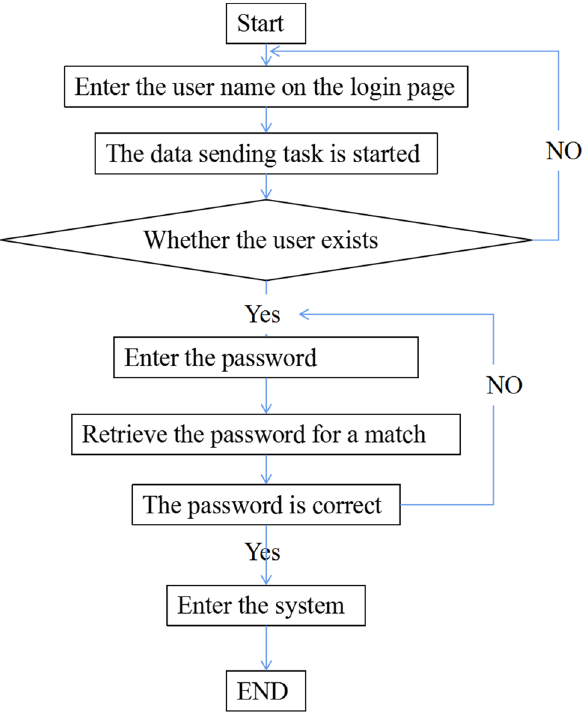
Figure 2: Flow chart of user login